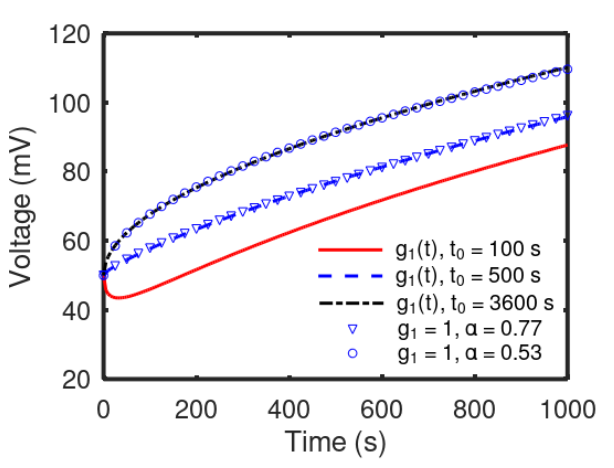
Figure 7. Voltage for a CPE with α = 0.5 and Q = 446 Ω − 1 Hz − 1 2 , measured after initializing at 50 mV. Approximation with g 1 = 1 by fitting the values of α = 0.5 and Q with the voltage